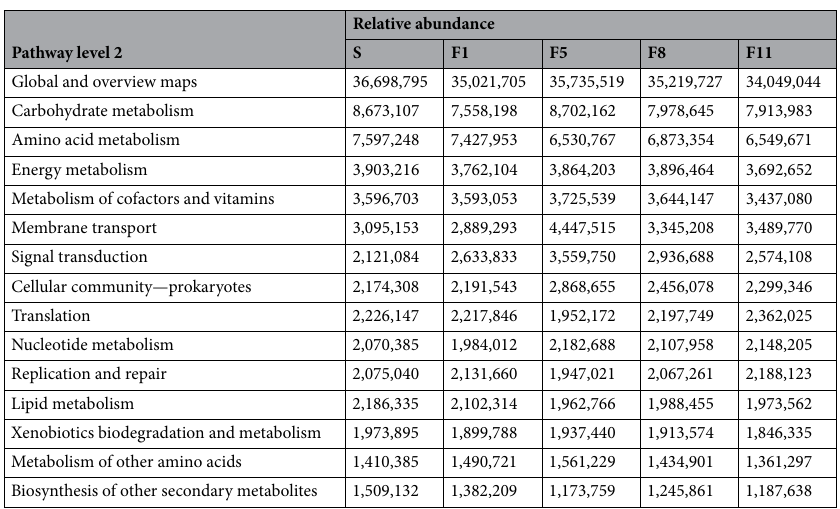
Table 2. Abundance of main metabolic pathways in KEGG level